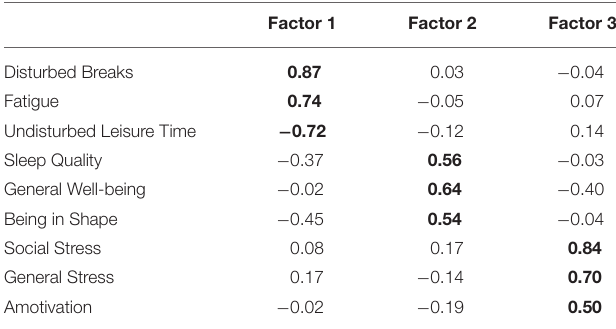
TABLE 6 | Exploratory Factor Analysis for a three factor solution for the sample of study 1.